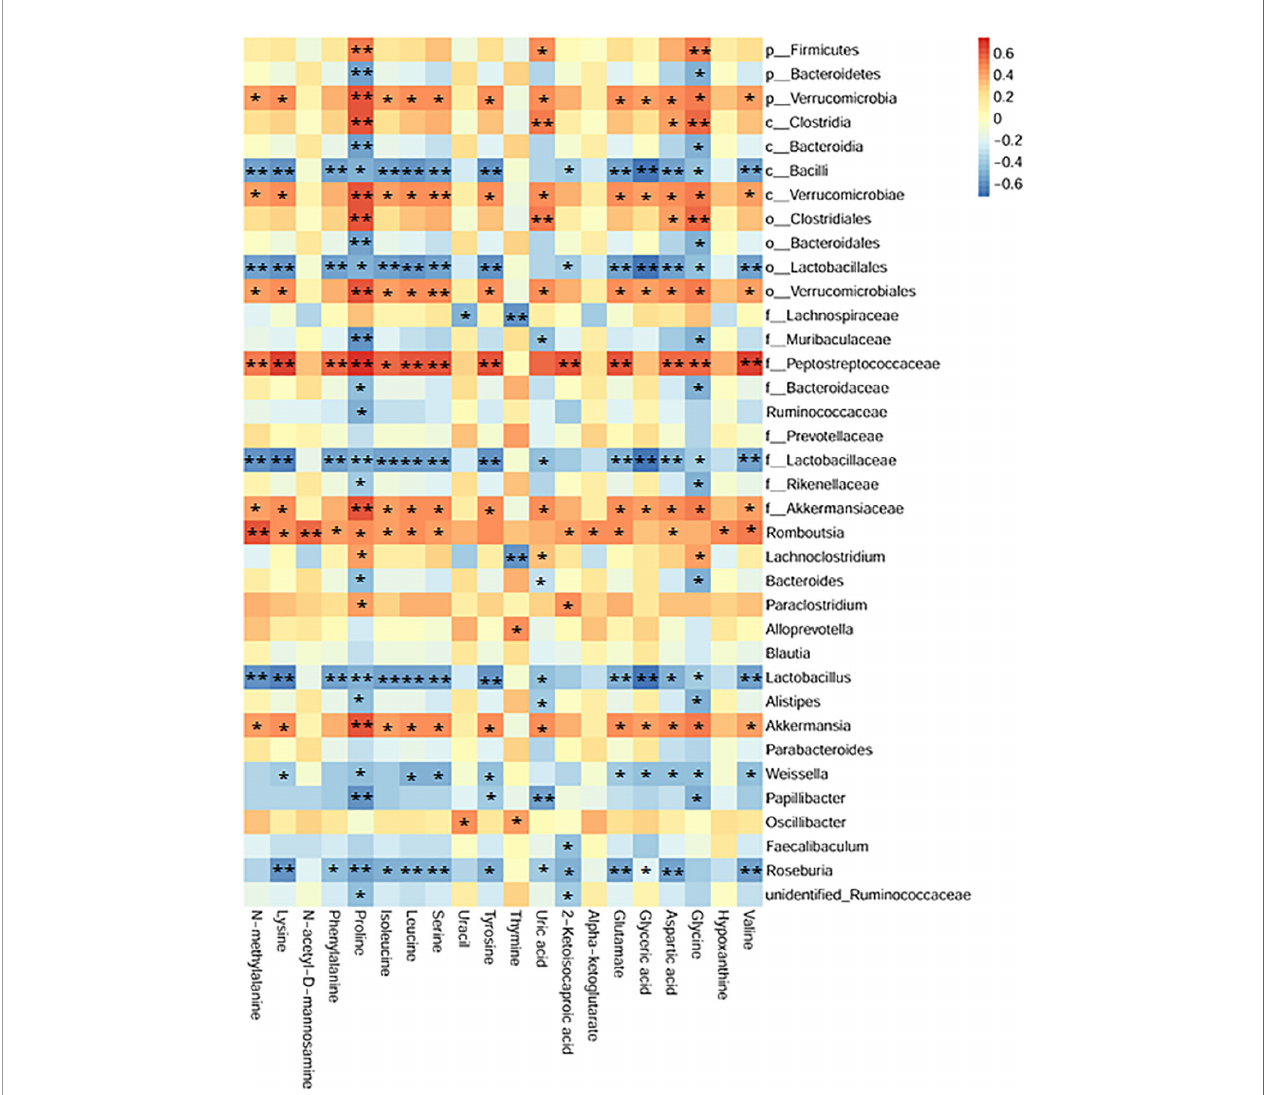
FIGURE 8 | Association map of the two-tiered analyses integrating the gut microbiome and fecal metabolome. The intensity of the colors represented the degree of association (red, positive correlation; blue, negative correlation). n = 24, Spearman ’ s coef fi cients, * P < 0.05, ** P <